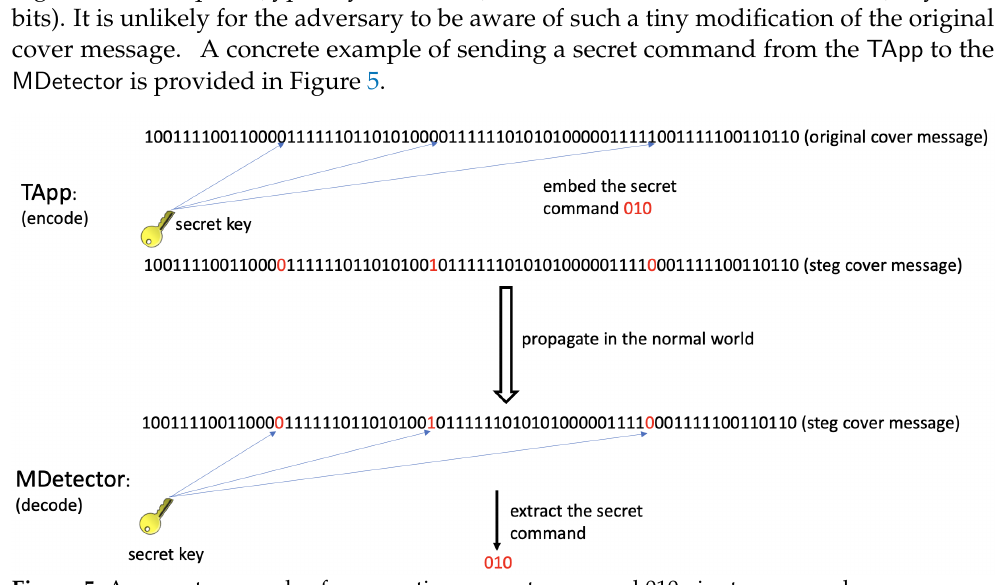
Figure 5. A concrete example of propagating a secret command 010 via